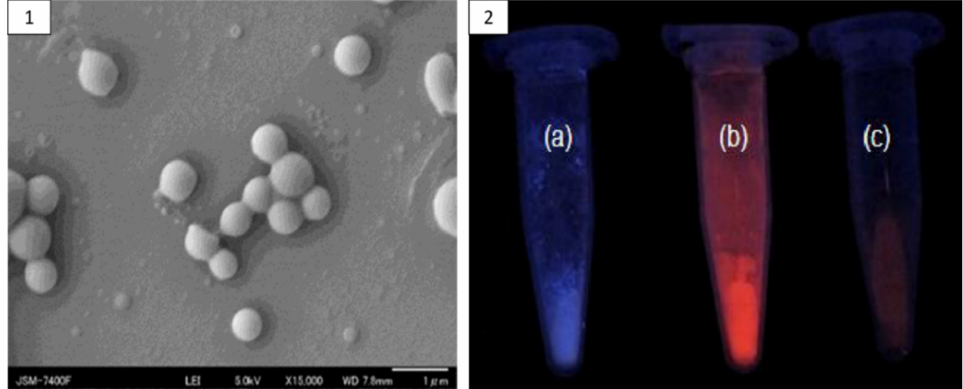
Figure 8. SEM Image of zein nanoparticles ( 1 ), and photograph of fluorescent ( a ) zein nanoparticle, ( b ) QD, and ( c ) zein QD under UV illumination ( 2 ). Reproduced with permission from [93], IOP- SCIENCE,